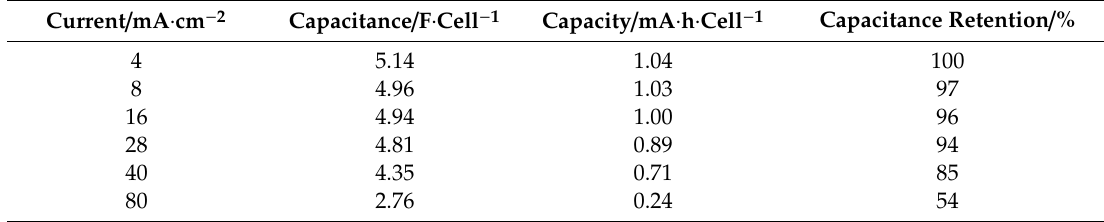
Table 1. Performance evaluation of the produced coin cells.